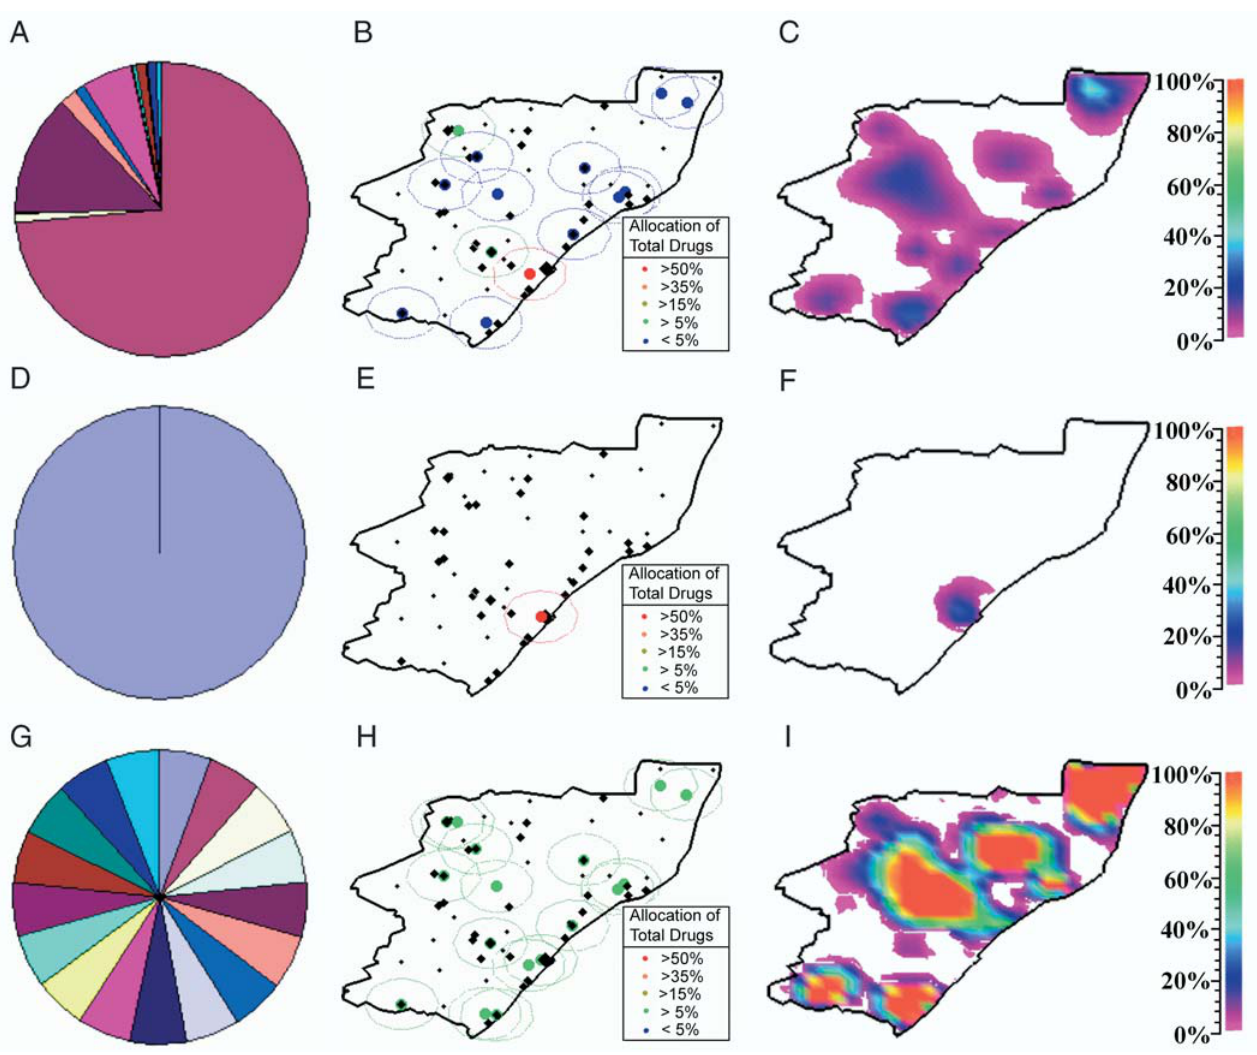
Figure 3. Pie Charts of the Three Strategies for Allocating ARVs to HCFs The three strategies considered are as follows: allocation of ARVs according to the results of minimizing our objective function (first row) allocation of ARVs only to one HCF in Durban (second row), allocation of ARVs equally to each of the 17 HCFs (third row). The proportion of ARVs allocated by these strategies to the 17 different HCFs is indicated in (A), (D), and (G), with each HCF represented by a different color. The spatial allocation of ARVs is shown in (B), (E), and (H), respectively. The respective percentage of infected people that are treated throughout the KwaZulu–Natal province is simulated in (C), (F), and (I). Here, the x–y plane represents spatial location, and the shaded color at a location refers to the proportion of individuals with HIV that are treated at the specified location. The plots were obtained by generating an interpolating surface where the z -ordinate, colored by magnitude, represents the proportion of treated individuals, and then orientating the view of the surface normal to the x–y plane. We performed surface data interpolation using the method of translates